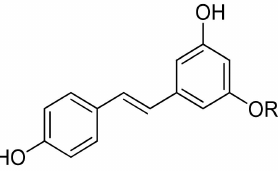
Figure 8. Structure of resveratrol (R = H) and resveratrol glucoside (R =